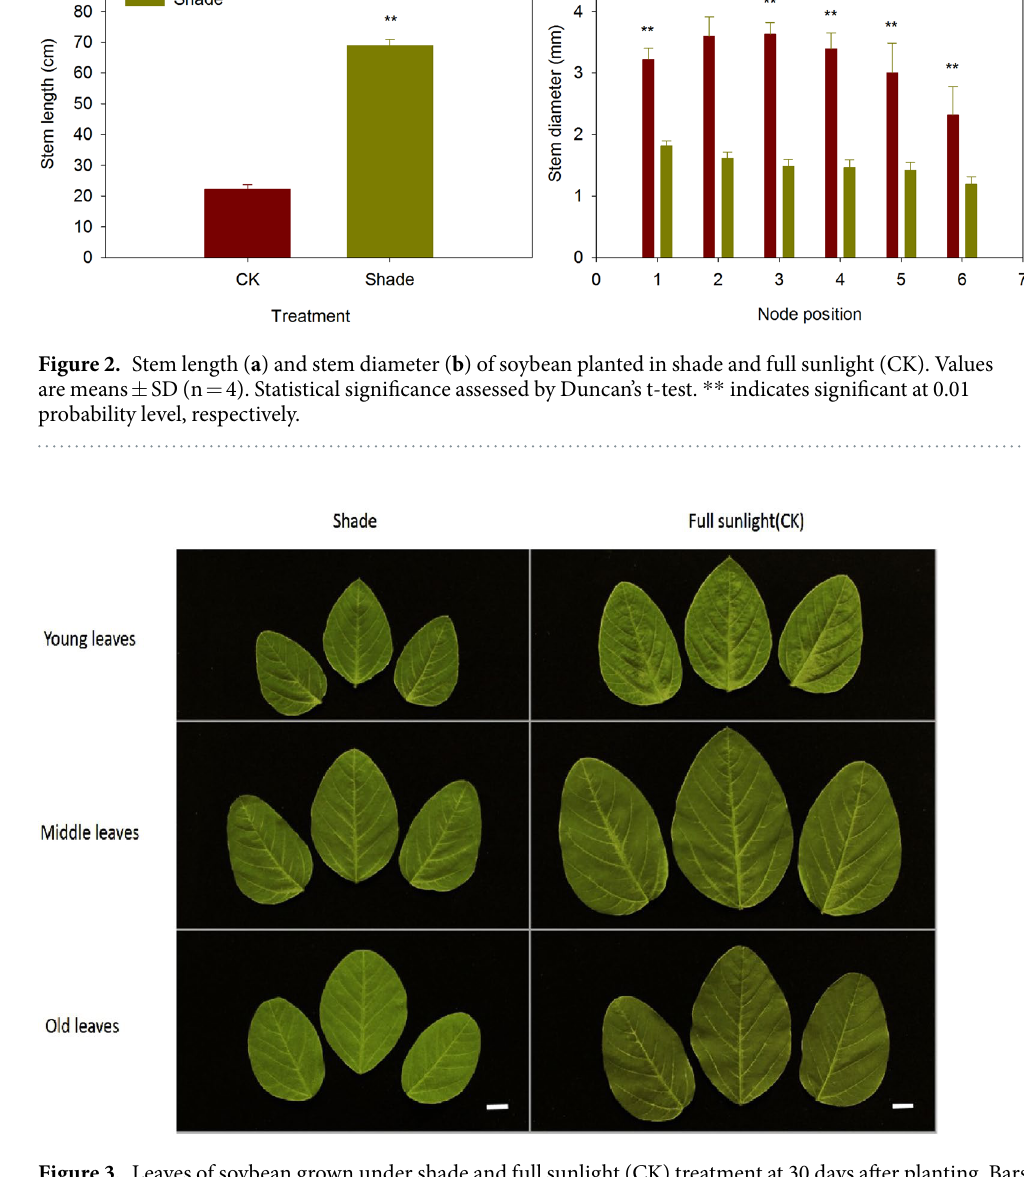
Figure 3. Leaves of soybean grown under shade and full sunlight (CK) treatment at 30 days after planting. Bars, 1